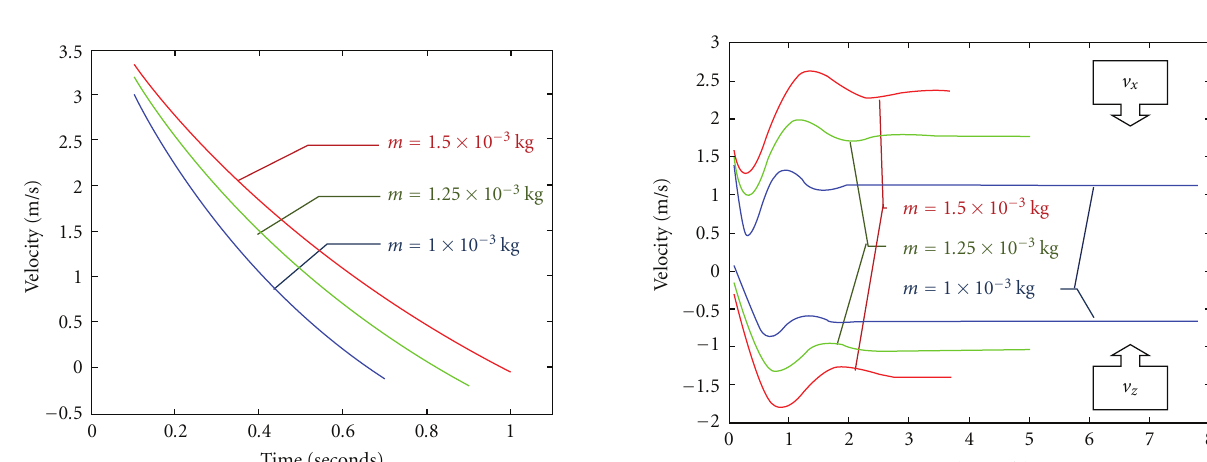
Figure 4: Dragonfly gliding straight—changing the weight. Angle of attack versus time.